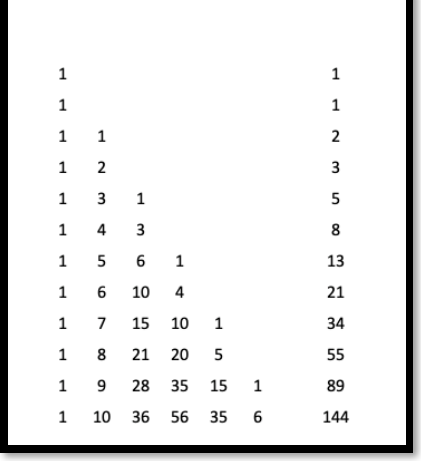
Figure 2. Rearranged Pascal’s triangle and Fibonacci numbers.